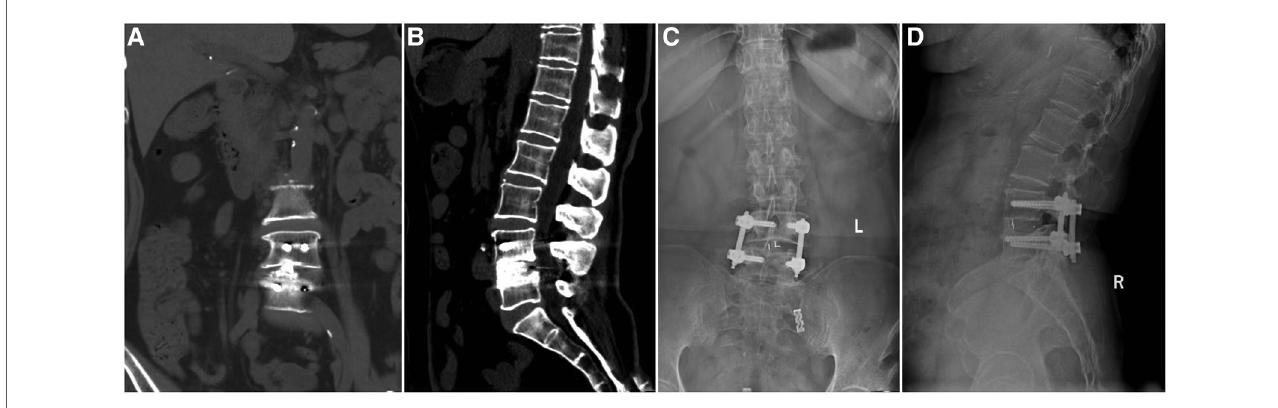
FIGURE 3 Imaging fi ndings during follow-up of a patient who underwent UBE-TLIF. ( A,B ) Coronal and sagittal CT showing that the cage was well positioned and high- density bone fusion between vertebral bodies 6 months after the operation. ( C,D ) 13-month postoperative x-ray showing bony fusion and that the instrumentation was in a good position.